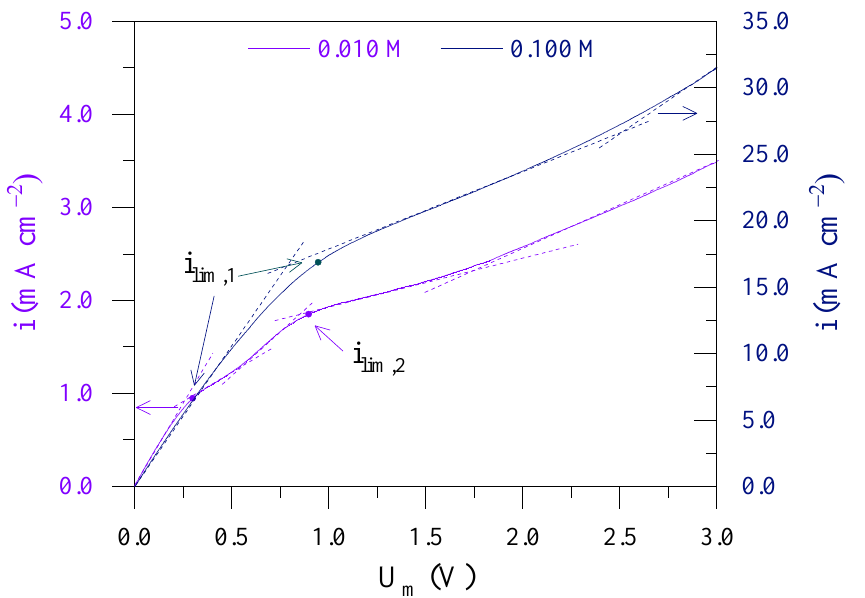
Figure 3. Polarization curves for the IONSEP-HC-A membrane in contact with a solution with 0.010 M and 0.100 M of H x PO 43 − x at pH 7.2. Dotted lines represent the delimitation of polarization curve regions.